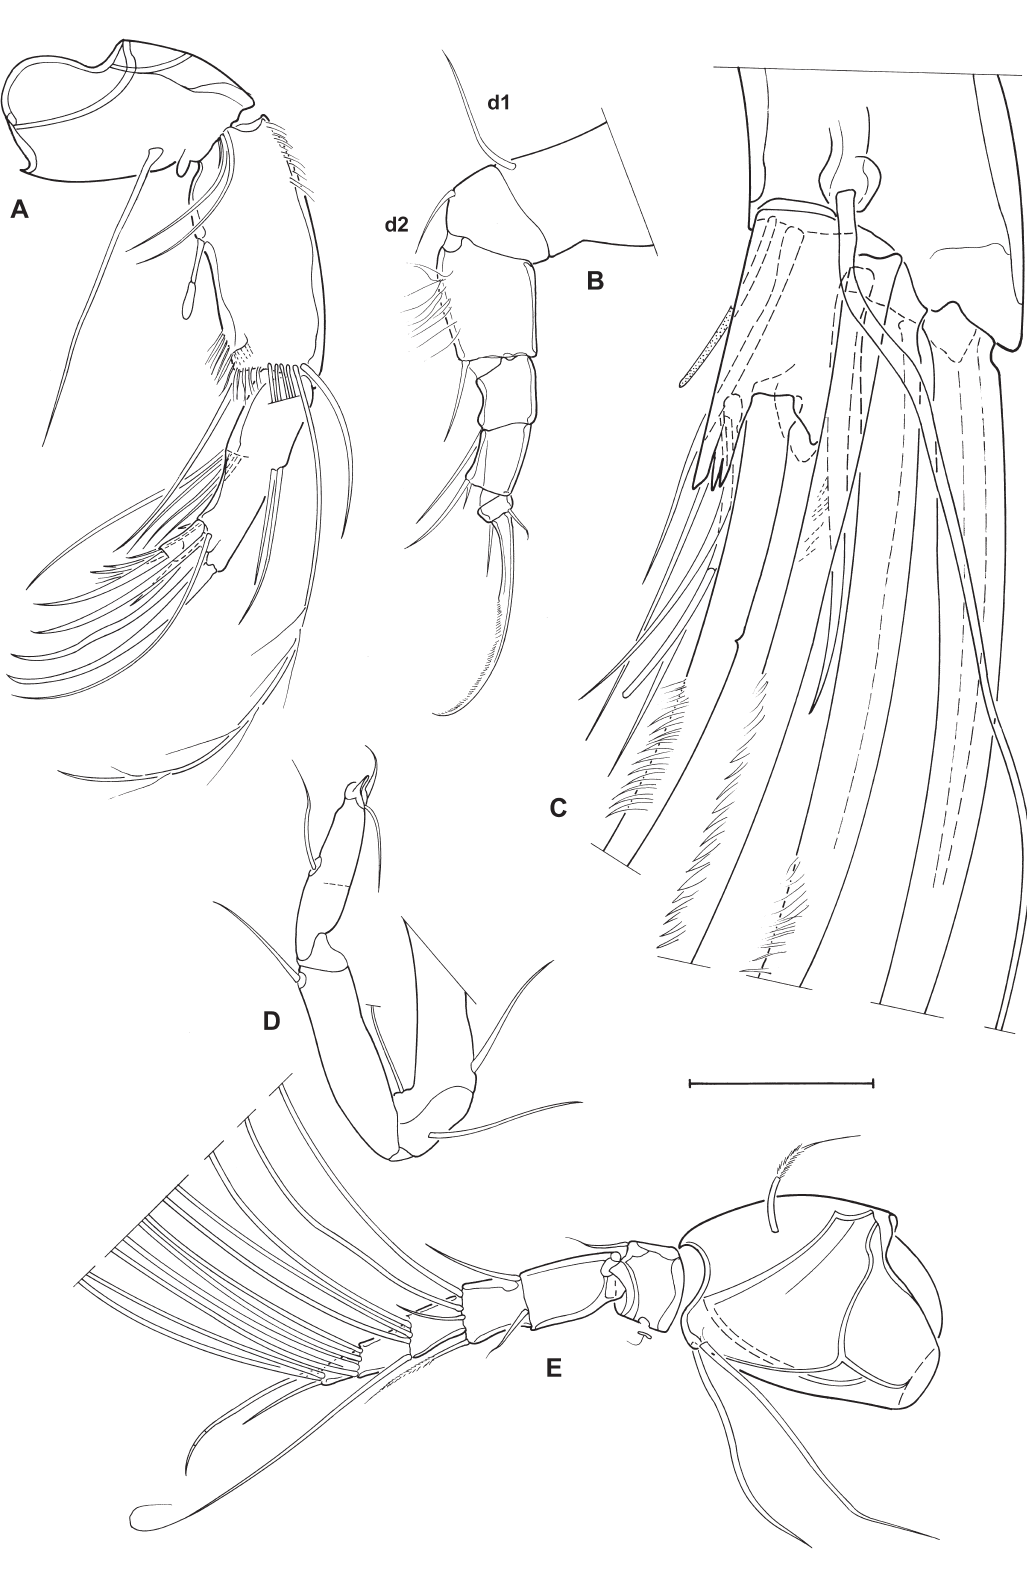
Fig. 6. Bennelongia cygnus sp. nov. (all from holotype ♂, WAM.C49370). A . A2. B . T2. C . A2, detail of distal chaetotaxy. D . T3. E . A1. Scales: A, B, E = 232 µm; D = 184 µm; E = 37